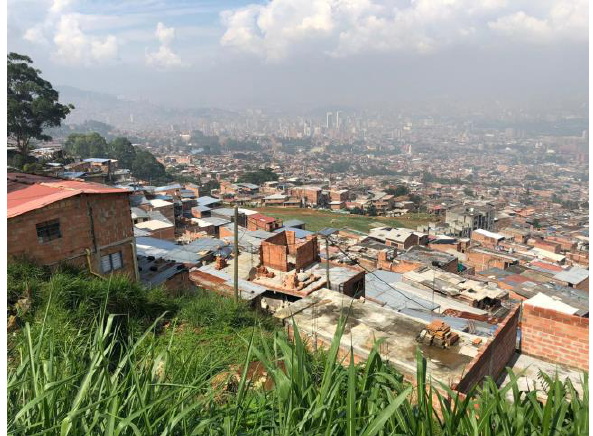
Figure 1. Photograph of the east side of the Aburrá valley, from the top of a mountain pointing at Medellín’s city centre (This Photo was made by the Team of the Technical University Munich in April 2019).